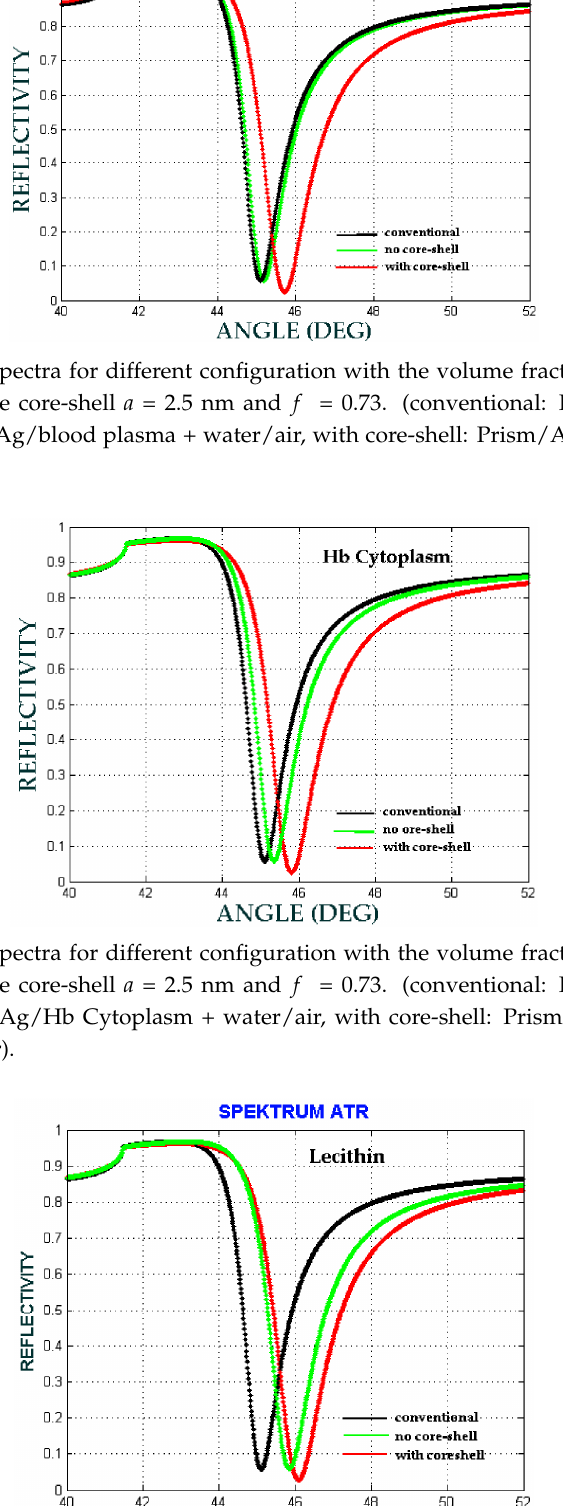
Figure 15. The ATR spectra for different configuration with the volume fraction of the composite F = 0.1, the size of the core-shell a = 2.5 nm and f = 0.73. (conventional: Prism/Ag/water/air, no core-shell: Prism/Ag/Lecithin + water/air, with core-shell: Prism/Ag/Fe 3 O 4 @Au + Lecithin + water/air). The angular shift of SPR angle have been showed at Table 4, where 1 θΔ is the angular shift between no core-shell configuration with the conventional configuration, whereas 2 θΔ is the angular shift between with core-shell configuration and no core-shell configuration. Table 4. Angular shit of SPR angle for different biomaterial sample detection.